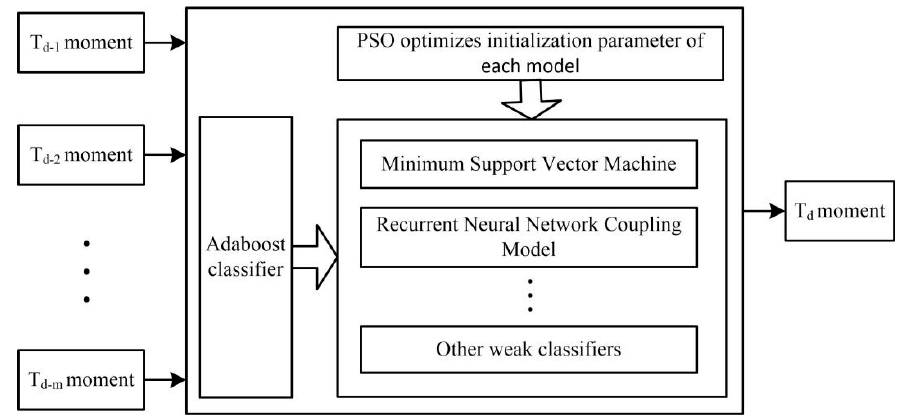
Figure 4. Integrated predictive control model at the same time in the future. The horizontal predictive control model algorithm process is described below.